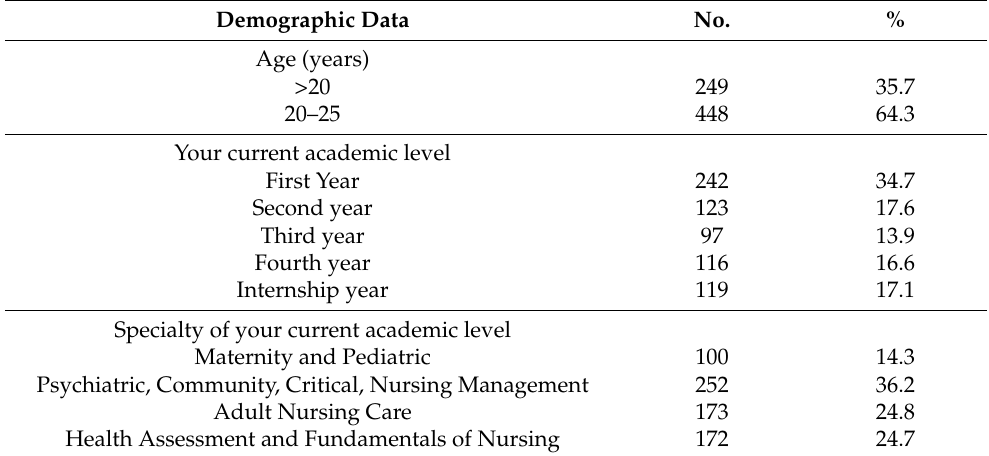
Table 1. Distribution of the studied nursing students according to their demographics ( n = 697).